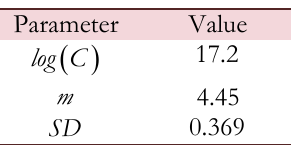
Table 5: Parameters of mean SN-curve.